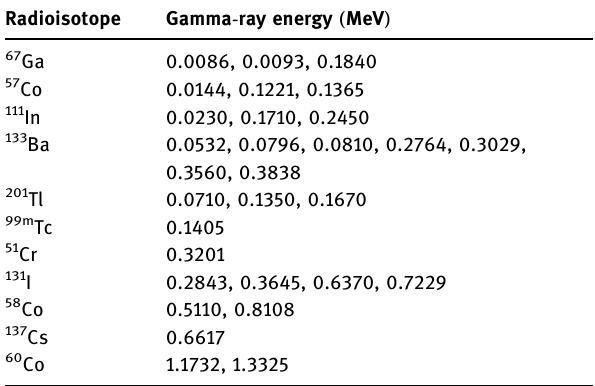
Table 2: Radioisotopes and gamma - ray energies used for gamma